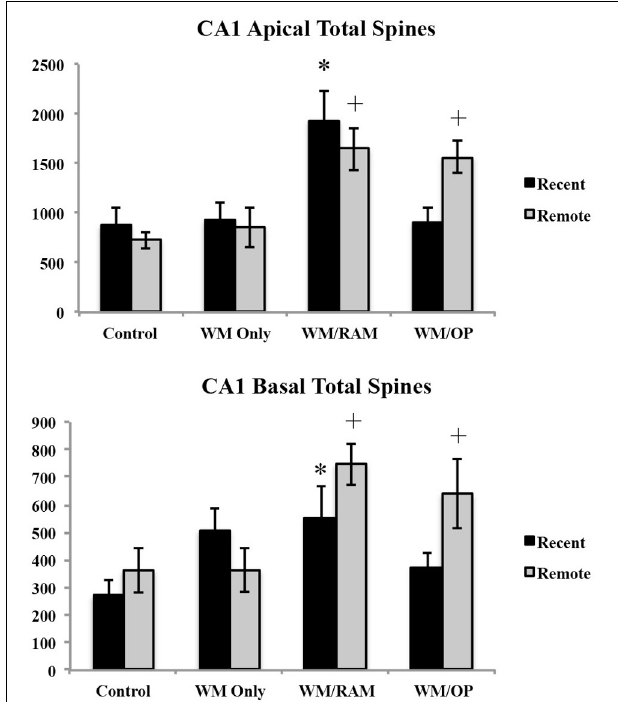
FIGURE 12 | Spine density in the CA1 in apical and basal dendrites. Only significant differences between behavioral groups and their respective control group are displayed. Refer to Results section for all comparison results. ∗ Significantly different from Control:recent group ( p < 0 . 05); + Significantly different from Control:Remote ( p < 0 .